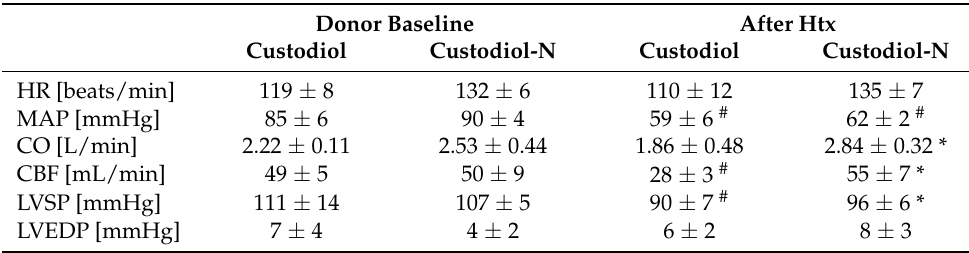
Table 2. Hemodynamic variables before and 2 h after orthotopic transplantation (Series 1: 4 h conservation time).